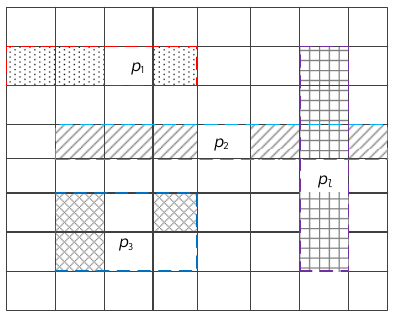
Figure 3. Example of merging